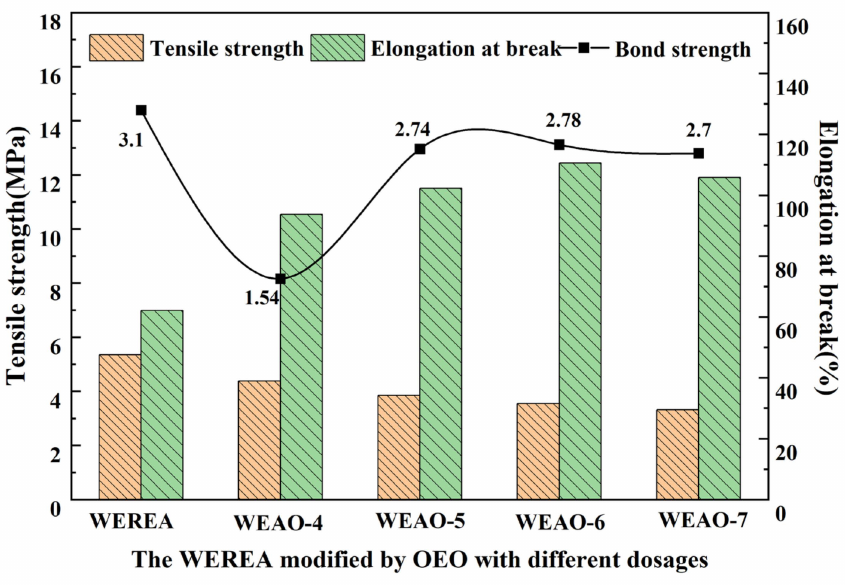
Figure 8. Mechanical properties of cured WEA and